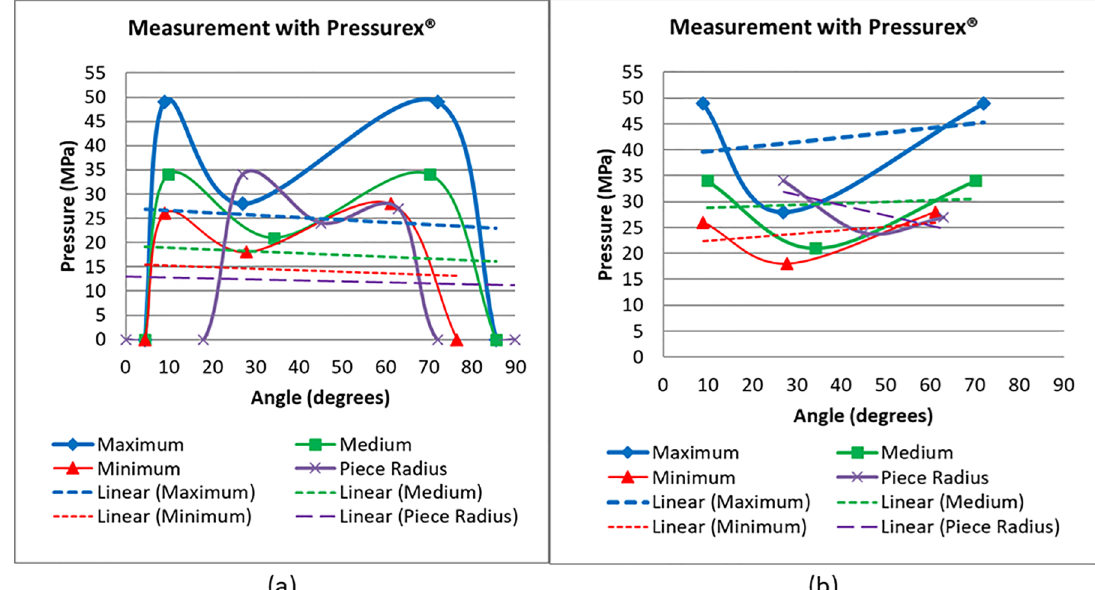
Figure 14. Pressure results obtained from Pressurex® films when the pin is fixed. Graph (a) shows the values considering the starting and ending points starting at zero and in graph (b) these points are